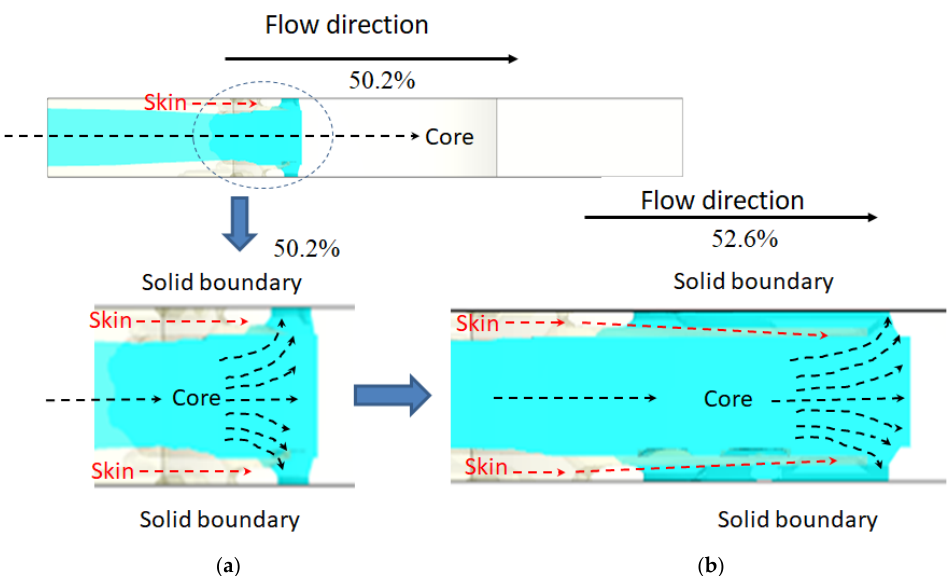
Figure 15. The dynamic behavior for core material advancement at skin to core of 30/70. ( a ) at 50.2% filled and ( b ) at 52.6% filled.